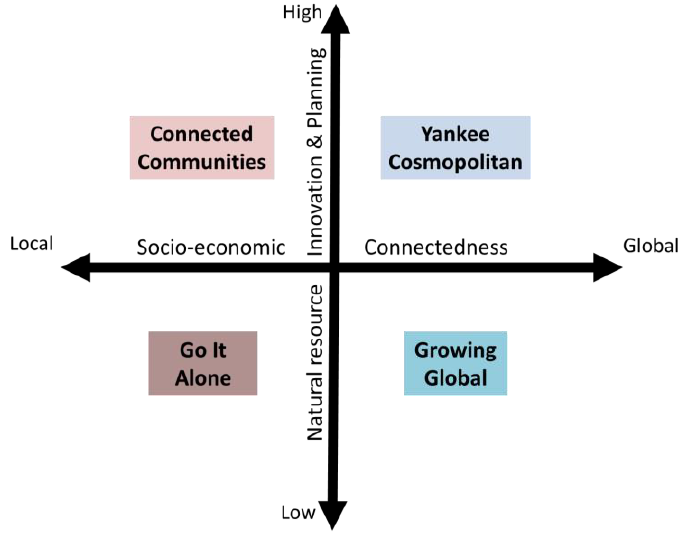
Fig. A3.1. New England regional scenario